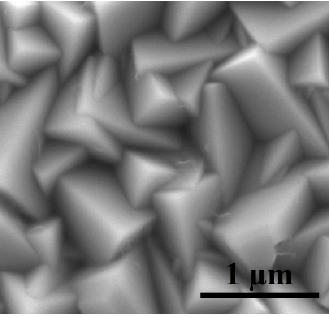
Figure 5. SEM image of Cu2O reference sample, fabricated in the absence of EDA.